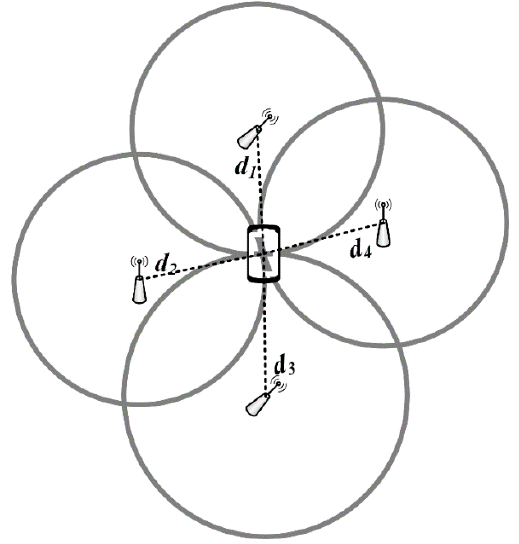
Figure 2. The positioning principle of the LS algorithm.